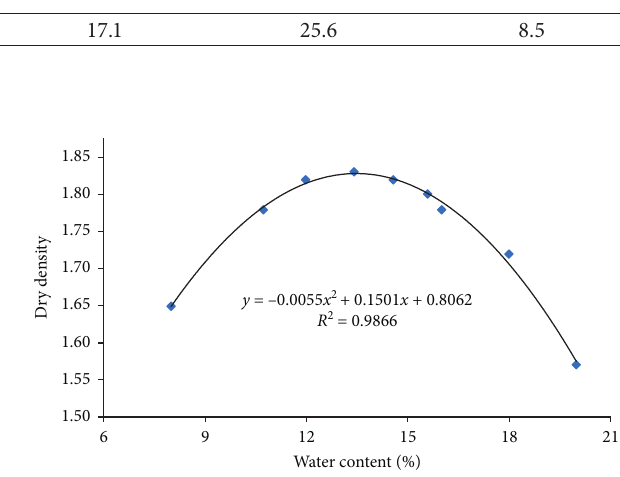
Figure 2: Compaction curve of loess